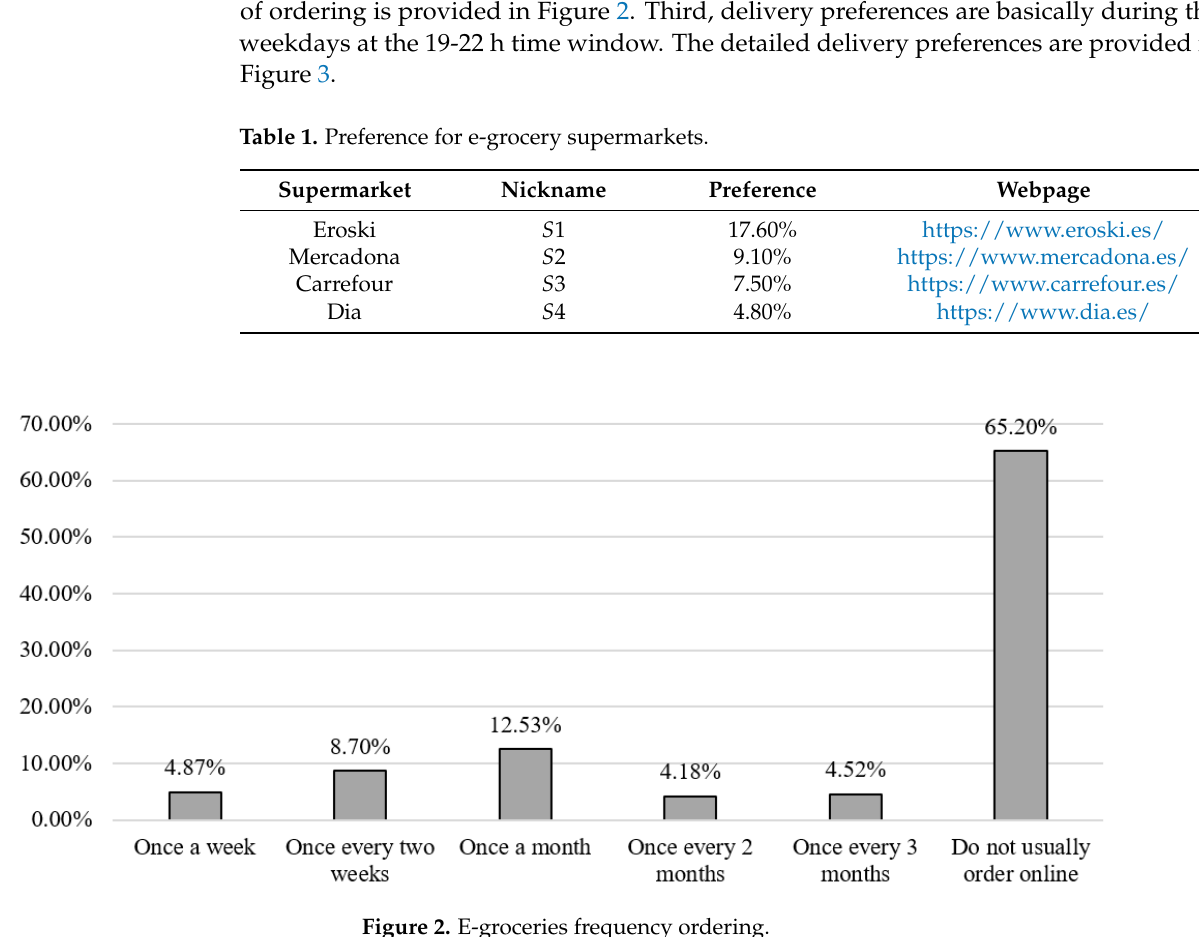
Figure 2. E-groceries frequency